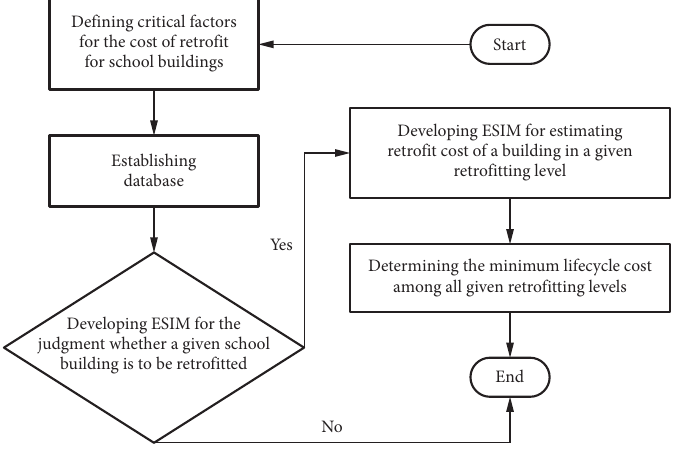
Figure 2. Inference framework for life-cycle cost of school buildings under seismic